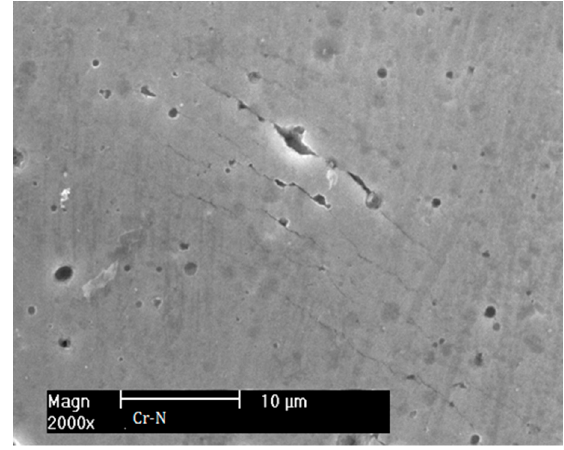
Figure 5. Development of a crack thorough pinholes in 4 μ m thick Cr-N coating deposited on X6CrNiTi18-10 austenitic steel by means of a cathodic arc evaporation method (own investigations).